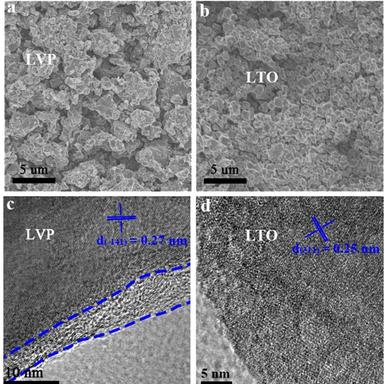
SEM images of (a) LVP/C and (b) LTO; HRTEM images of (c) LVP/C and (d) LTO.